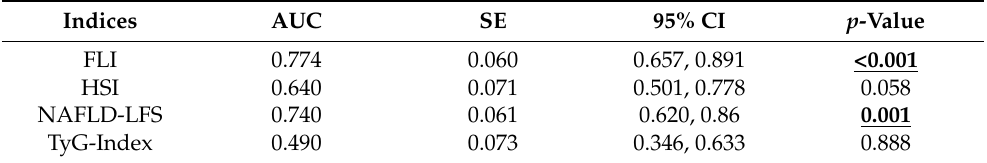
Table 5. Area under the receiver operating characteristic (ROC) curve (AUC) and its 95% CI for different indices with NAFLD in patients with type 2